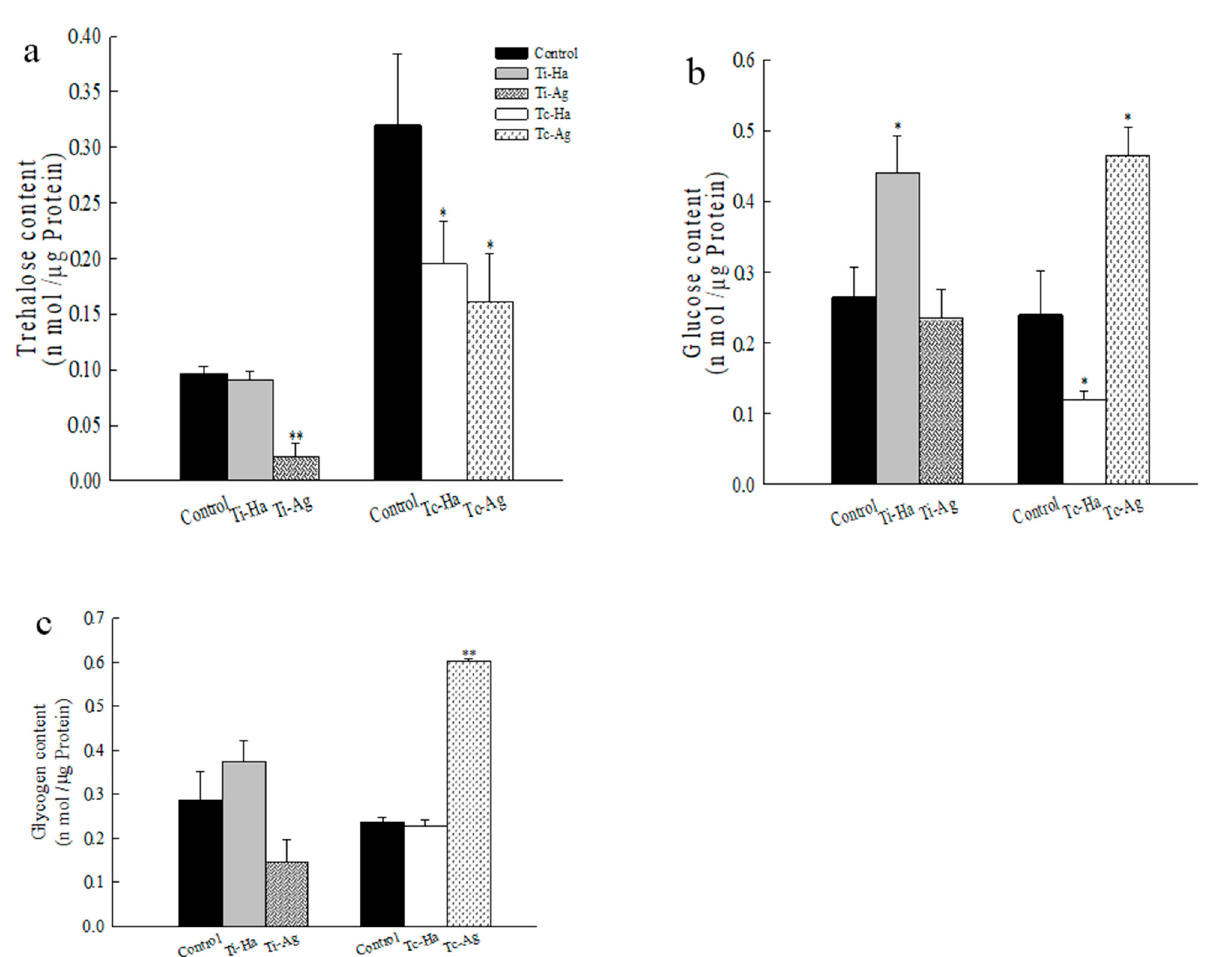
Figure 5. ( a ) Trehalose content changes in ladybirds. ( b ) Glucose level change in ladybirds. ( c ) Glycogen content changes in ladybirds. * and ** in the column represent significant and extremely significant differences from the control group at 0.05 and 0.01 (one-way ANOVA), respectively.